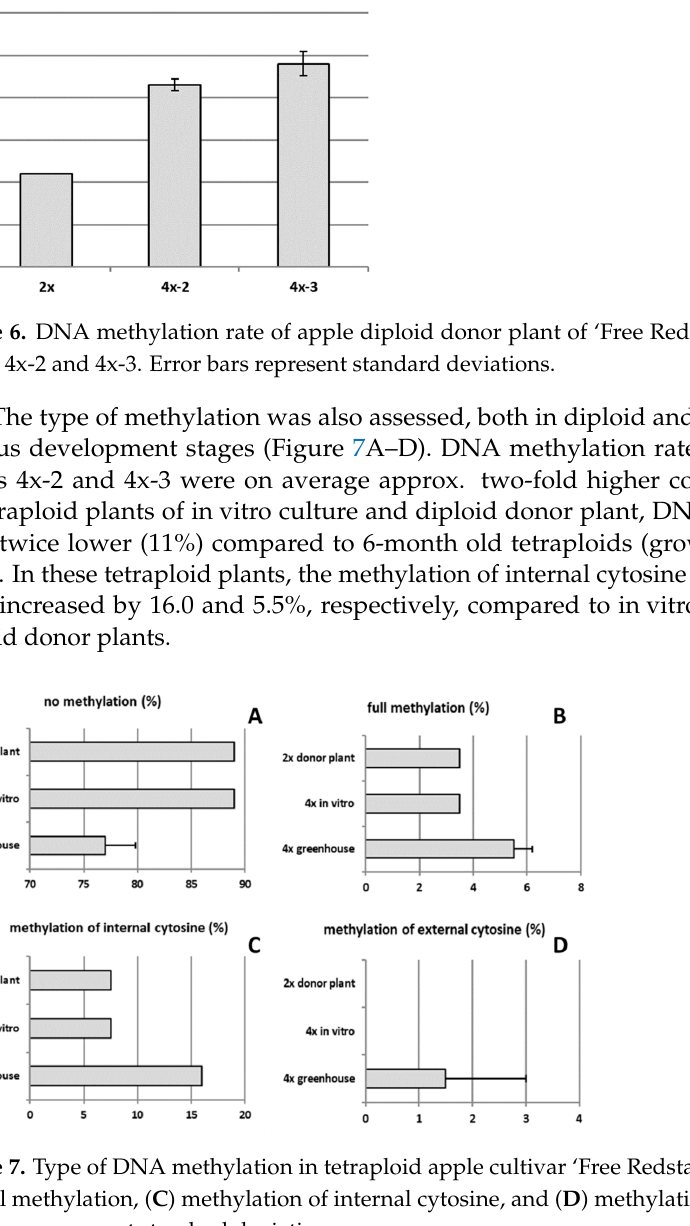
Figure 7. Type of DNA methylation in tetraploid apple cultivar ‘Free Redstar’: ( A ) no methylation, ( B ) full methylation, ( C ) methylation of internal cytosine, and ( D ) methylation of external cytosine. Error bars represent standard deviations.